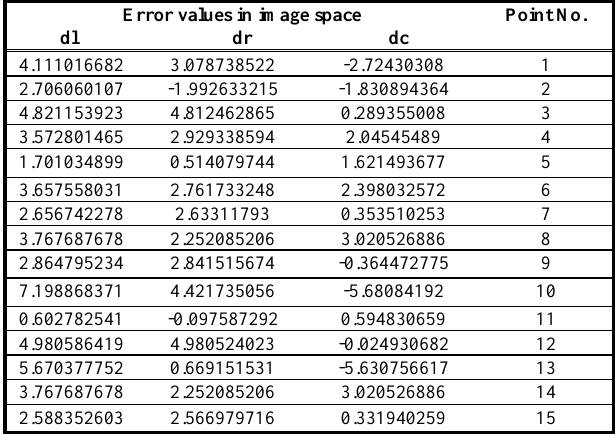
Table 3. The error values in the image space for each of the points According to the Table 3, RMSE and STD values are calculated as 3.9666 and 1.6206 pixels, respectively.